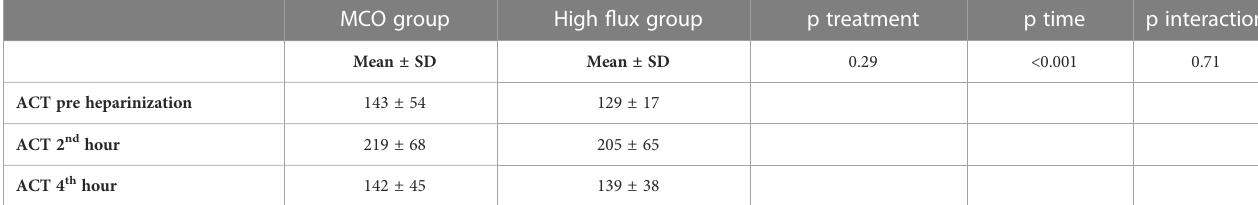
TABLE 3 ACT measurements during dialysis sessions before and after 12 weeks of treatment with MCO/High- fl ux